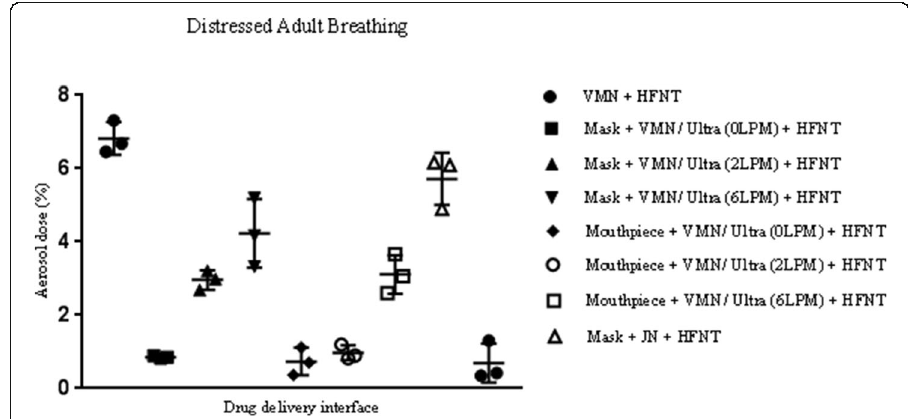
Fig. 5 Illustration of aerosol dose (percentage) for each delivery modality with concurrent HFNT, during simulated distressed adult breathing. The values represented are mean ± standard deviation (expressed in percentage) of three independent